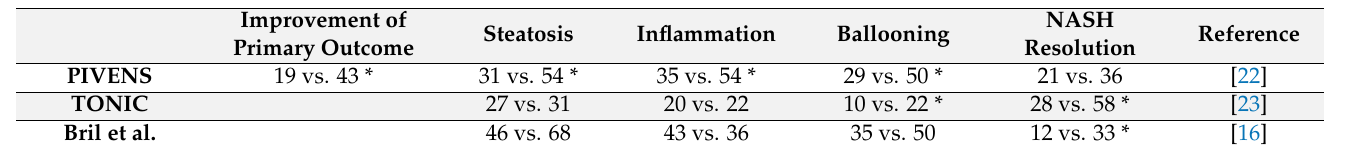
Table 1. Percentage of patients (placebo vs. vitamin E) showing at least a one-point improvement in histological parameters. Statistical significance for the comparison vitamin E treatment to placebo: * p <